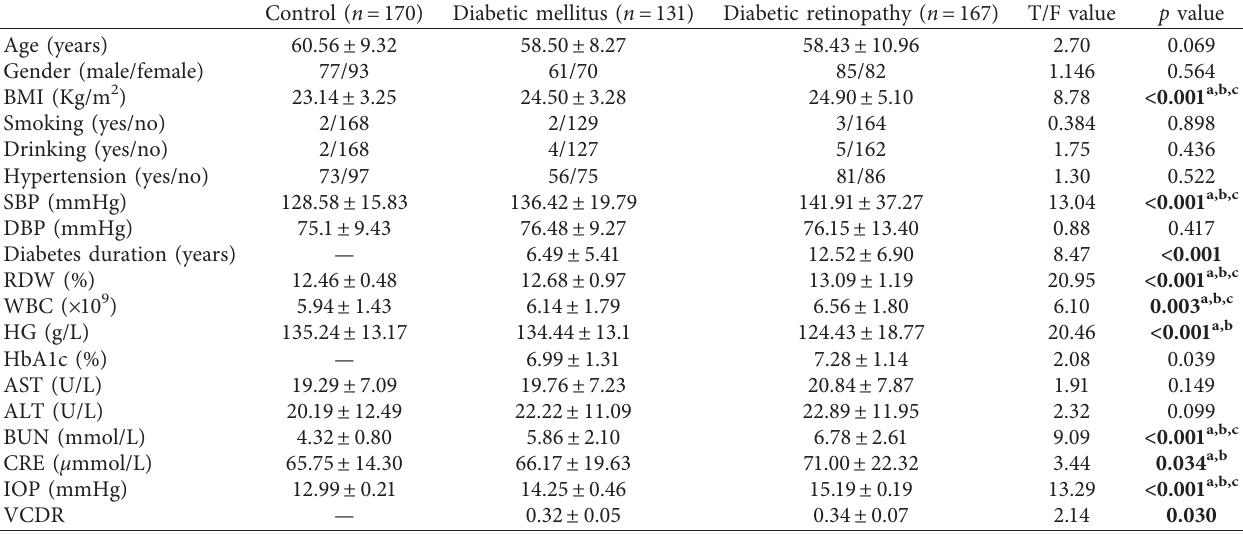
Table 1: Demographic characteristics and clinical data of the study population.